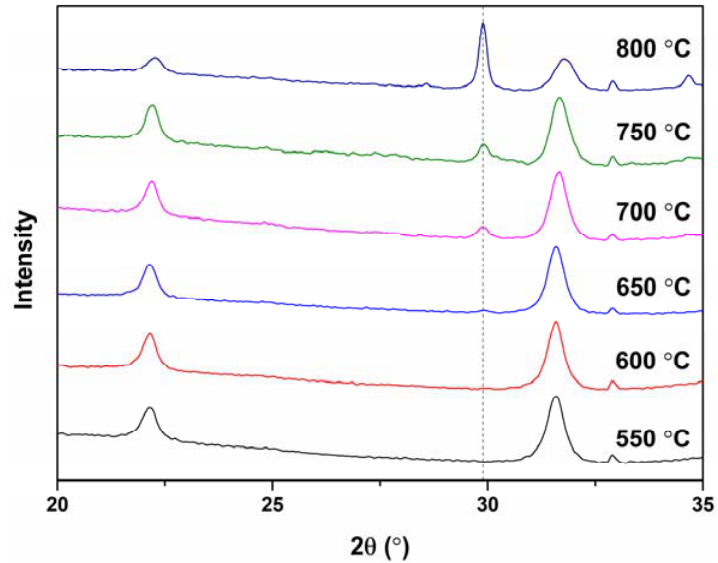
4 Figure 4. XRD patterns of the BLFSO films annealed at different temperatures (Pt/TiO /Si